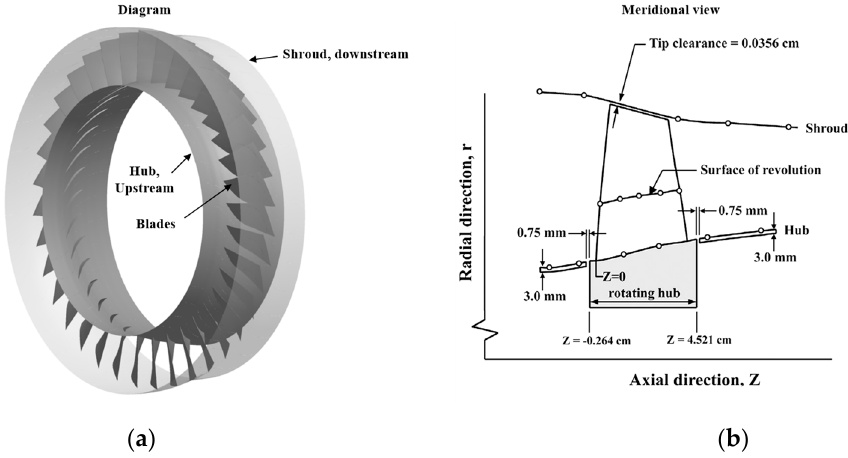
Figure 6. Representation of Rotor 37. ( a ) The diagram of Rotor 37; ( b ) The meridional view of Rotor 37.